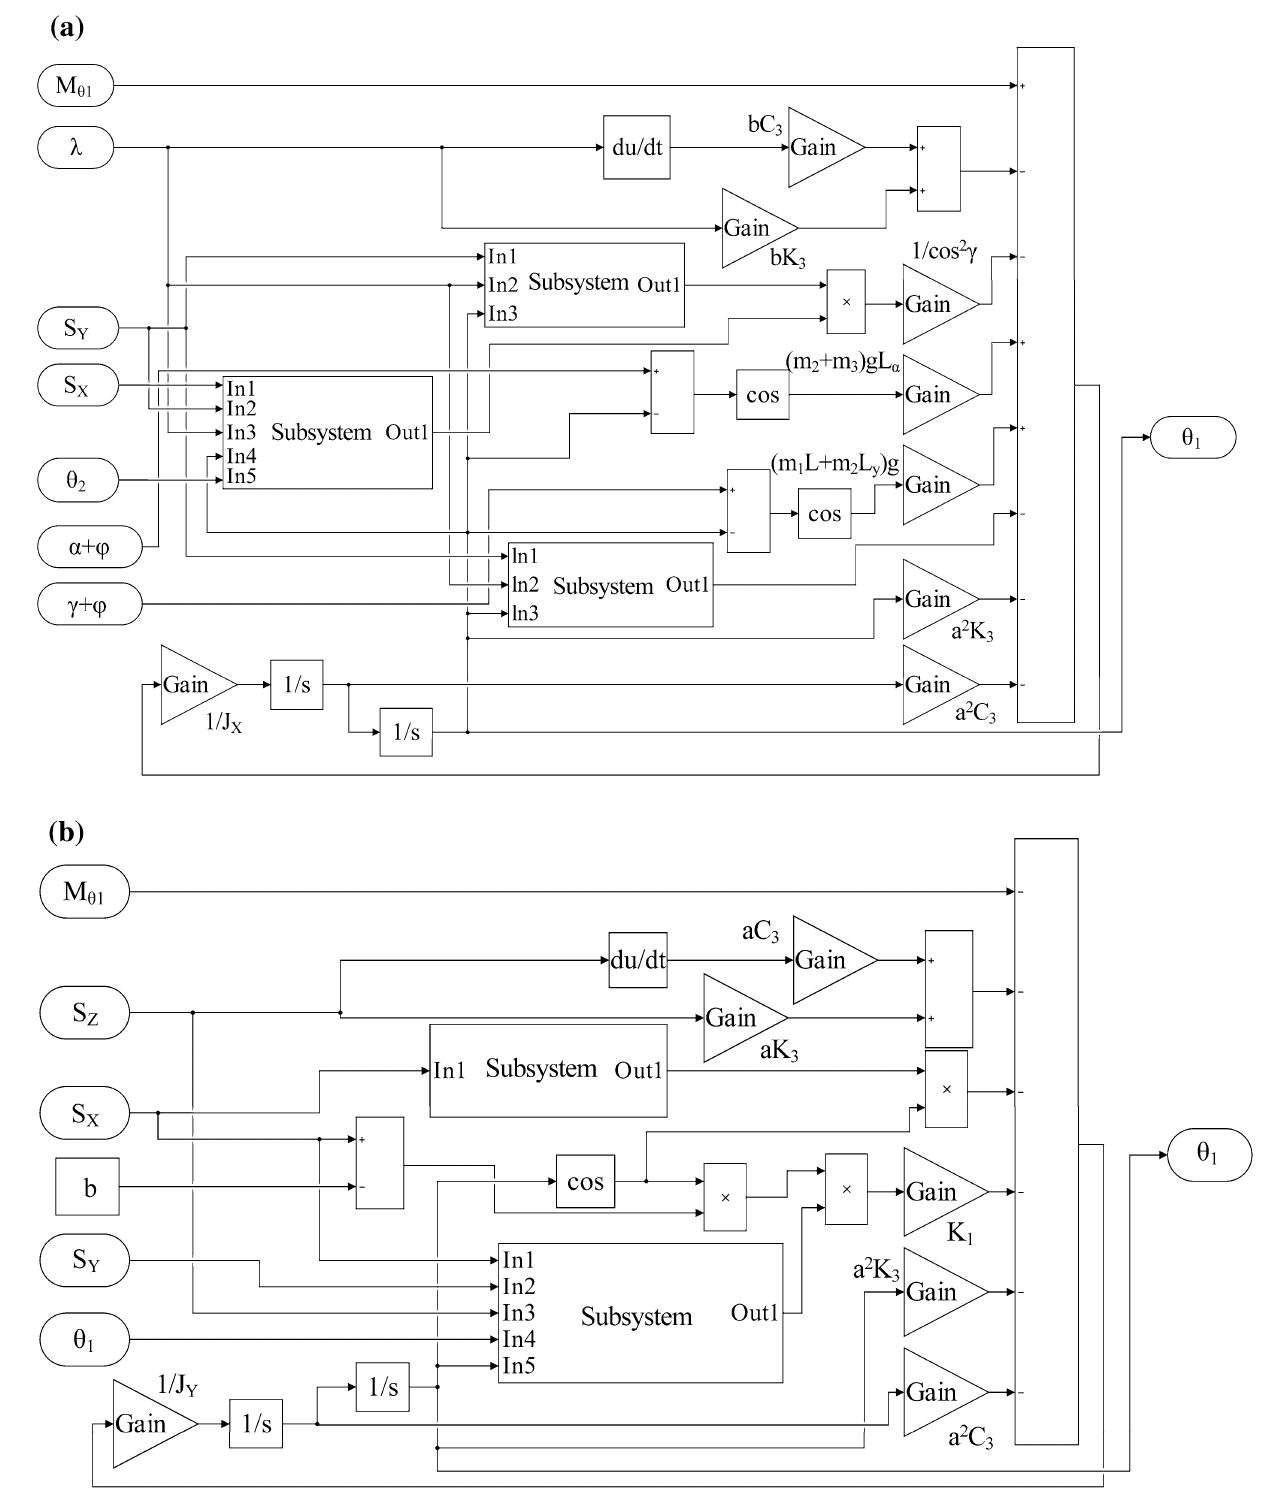
Fig. 8 Simulink system of solving the dynamical model. ( a ) Solving the pitch angle θ angle θ during horizontal cutting process; ( d ) Solving the deviation angle θ 3